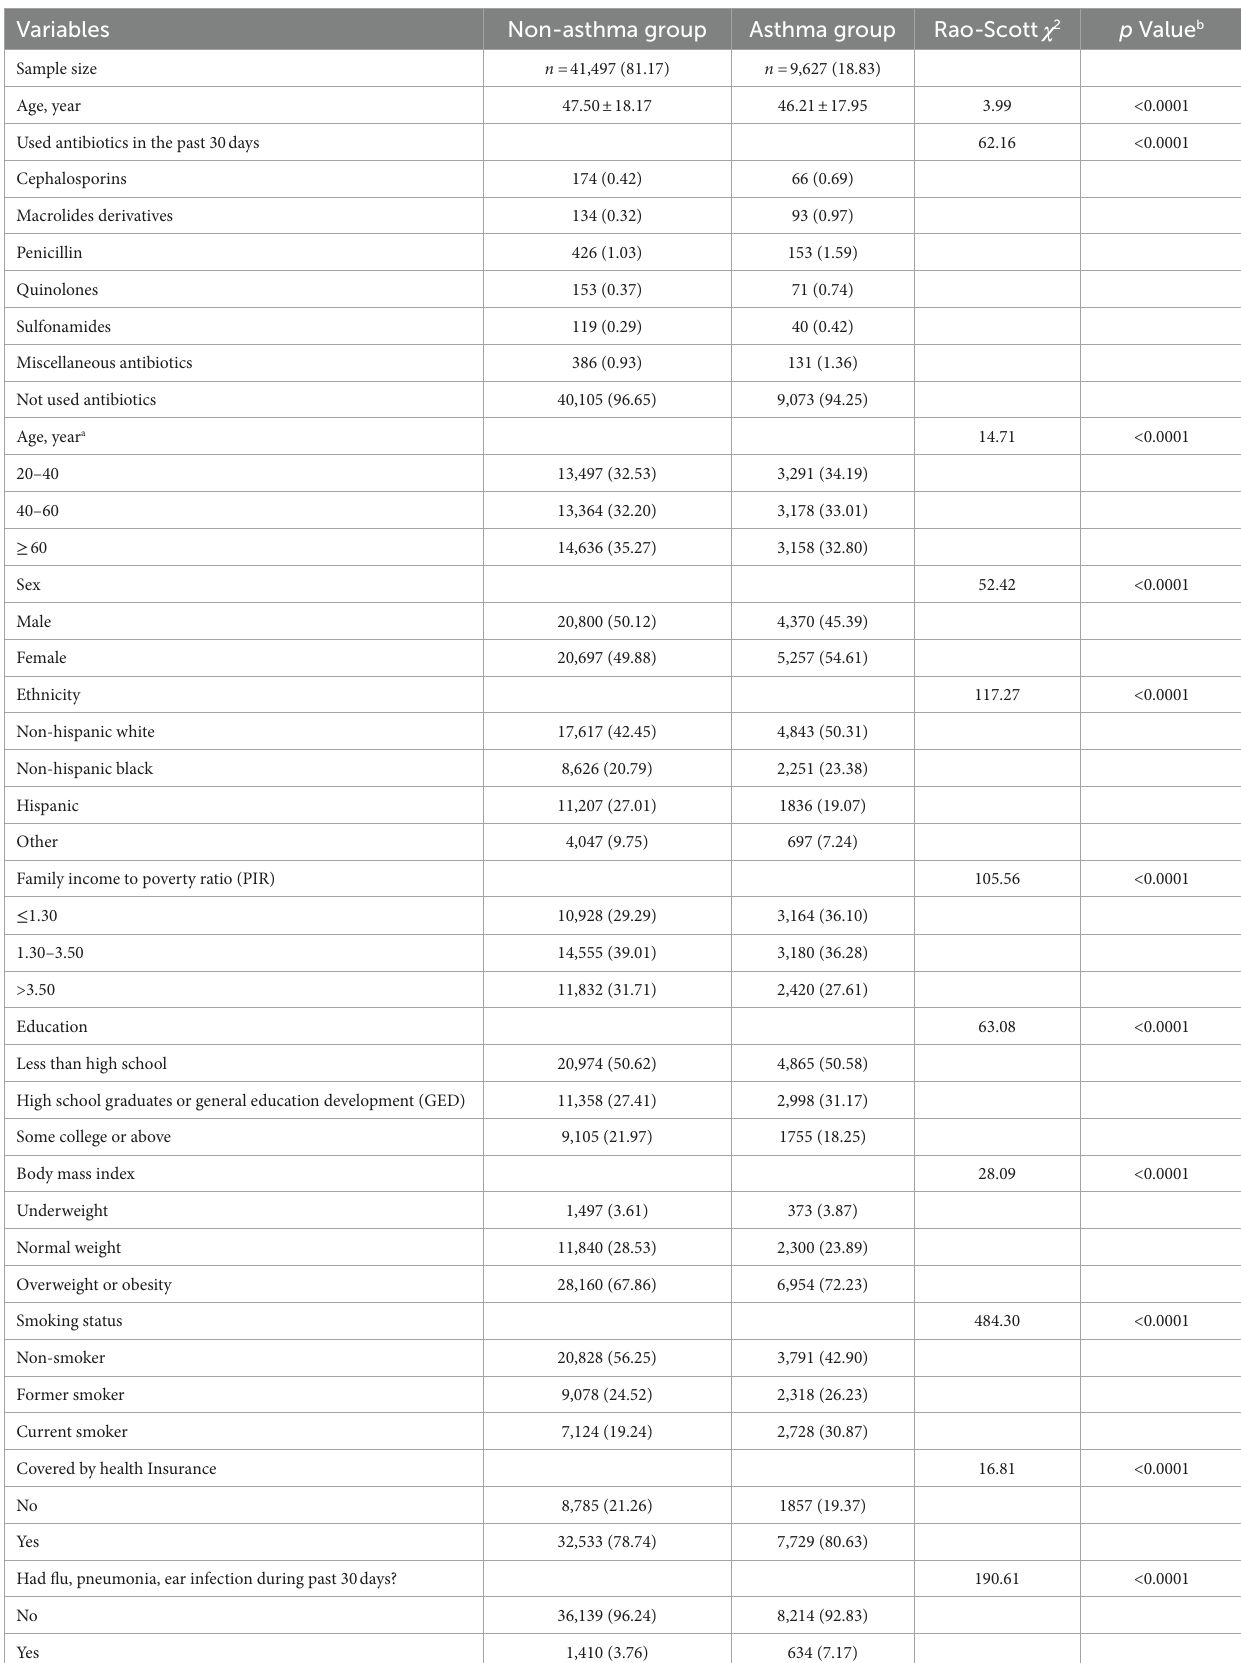
TABLE 1 Characteristics of participants aged over 20 by asthma status: NHANES